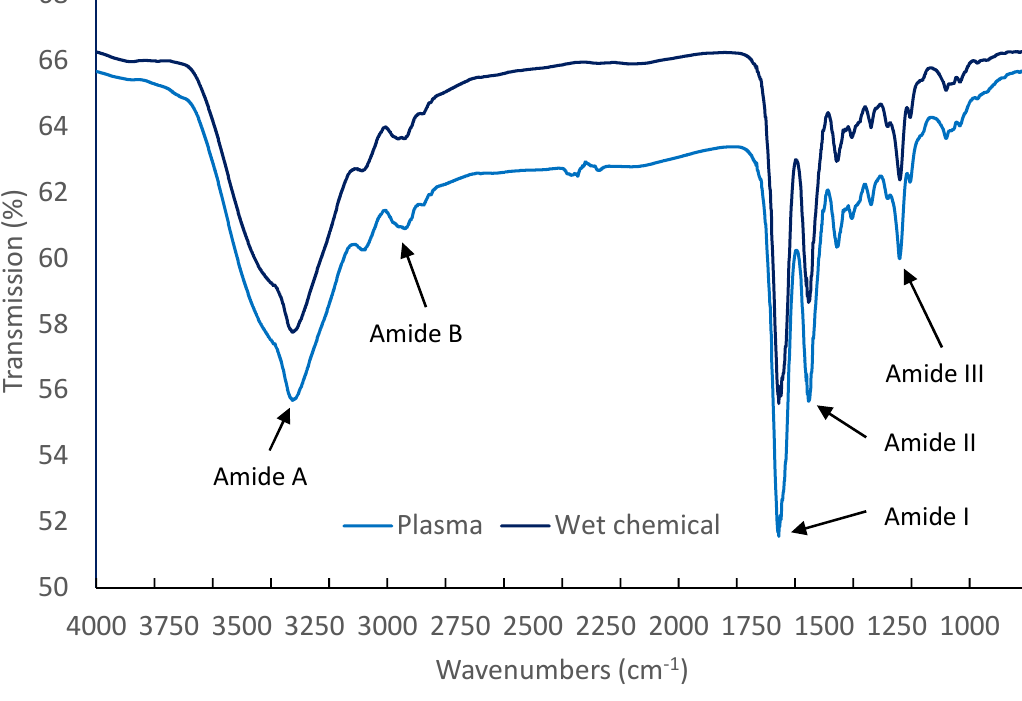
Figure 7. Fourier transform infra-red (FTIR) spectra of collagen coating deposited using traditional wet chemical technique and plasma deposited collagen.